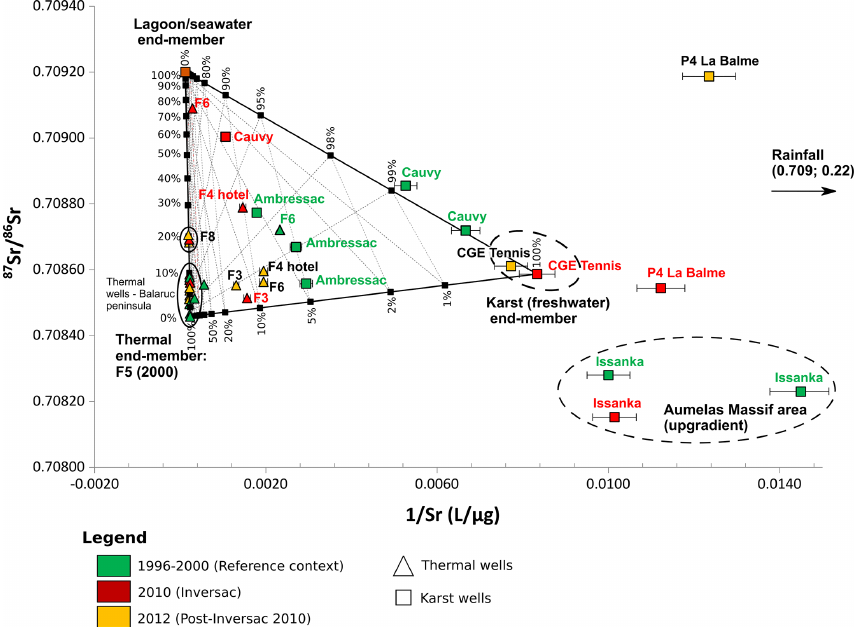
Figure 8. Plot of 87 Sr / 86 Sr ratio versus Sr concentration (as 1 / Sr) for springs and wells of the Balaruc peninsula for different hydrogeological situations: pre-inversac reference (green), 2010 inversac (red), and 2012 post-inversac